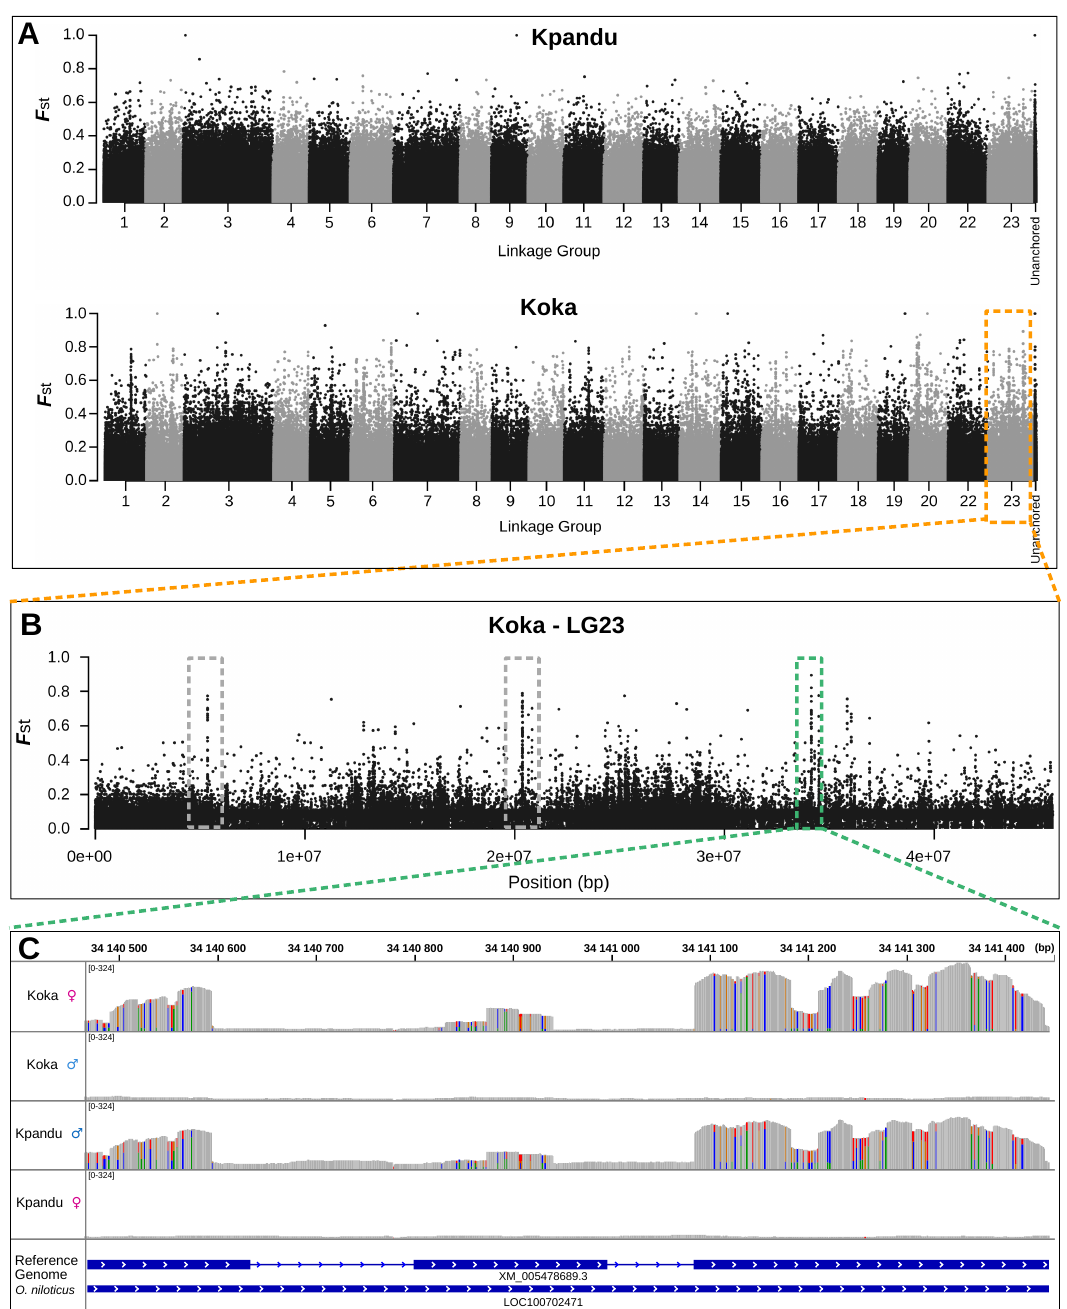
Figure 5. SNPs associated with phenotypic sex obtained from the WGS. ( A ) Manhattan plots of F ST for Kpandu and Koka populations obtained with Sex SNP Finder. High F ST peaks are observed on every LG meaning there is a signal associated to sex on all chromosomes; ( B ) Close up of F ST on LG23 for Koka showing three high Fst regions in grey and green boxes; ( C ) Integrative Genomics Viewer (IGV) plot of sequence coverage at ~34.14 Mb on LG23 corresponding to the green box above for both sexes of the two wild populations. High F ST values in this region are due to a very high sequence coverage ( > 10 times the mean coverage) likely corresponding to repetitive sequences on the B chromosome. SNPs are represented by colour traits with a bicolour trait being a polymorphic site, with the size of the colour band proportional to the nucleotide frequency. Frequencies of SNPs are conserved between Kpandu males and Koka